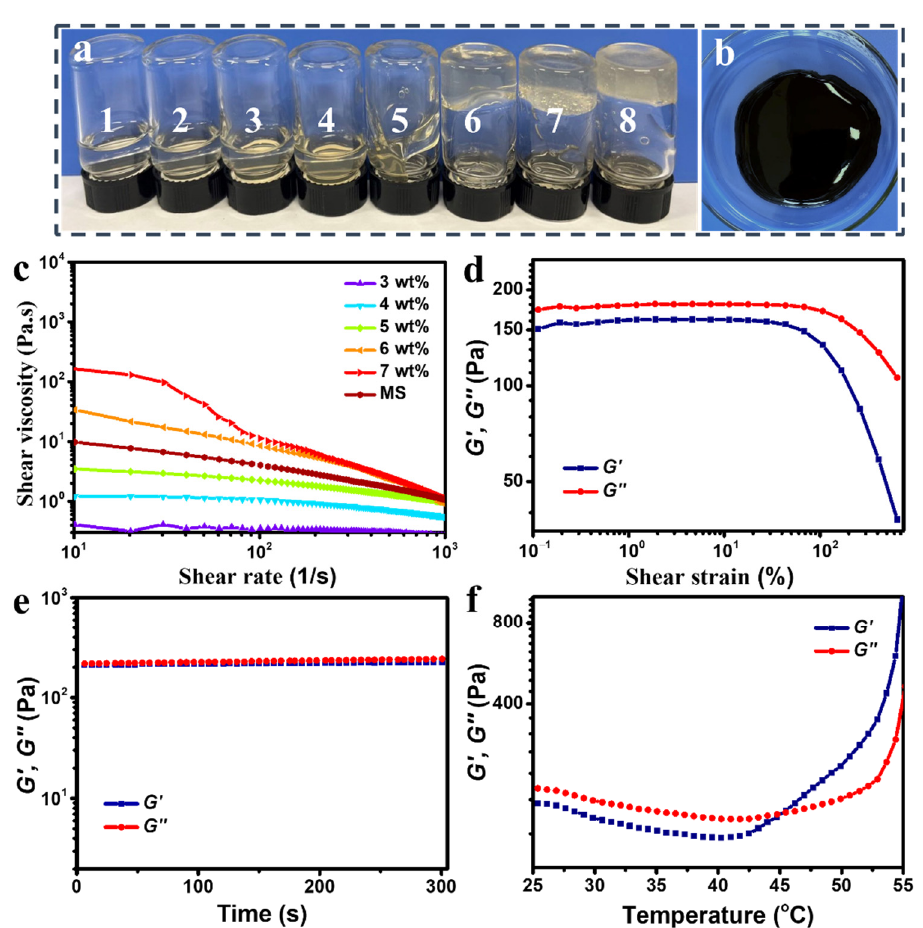
Figure 2. ( a ) Photograph of PC-CS at different concentrations (labels 1 to 8 refer to the concentration of 1 wt% to 8 wt%. ( b ) Photograph of an MS (3 wt%). ( c ) The apparent viscosity of PC-CS at different concentrations plotted as a function of shear rate. ( d ) Shear and loss storage modulus of PC-CS (6 wt%) with strain varying from 0.1% to 700% at a fixed frequency of 1 Hz. ( e ) Shear and loss storage modulus of PC-CS (6 wt%) with time changing from 0 to 300 s. ( f ) Shear and loss storage modulus of PC-CS (6 wt%) with temperature increasing from 25 °C to 55 °C.